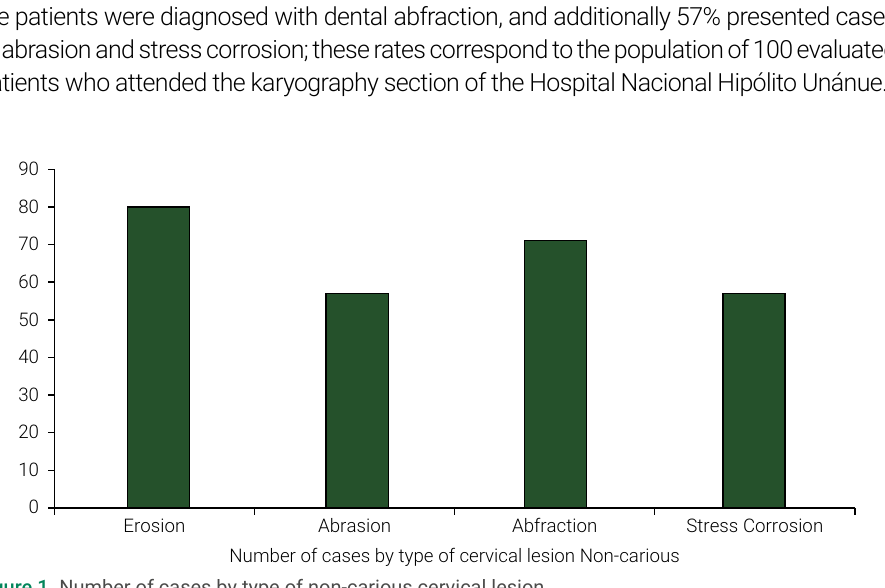
Figure 1. Number of cases by type of non-carious cervical